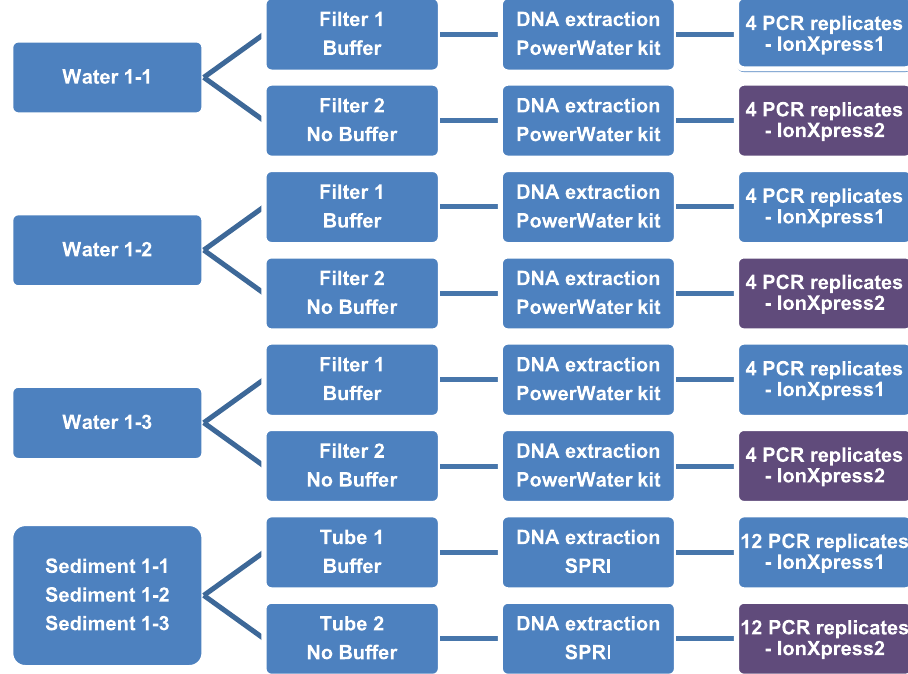
Fig 2. Experimental design for the water and sediment